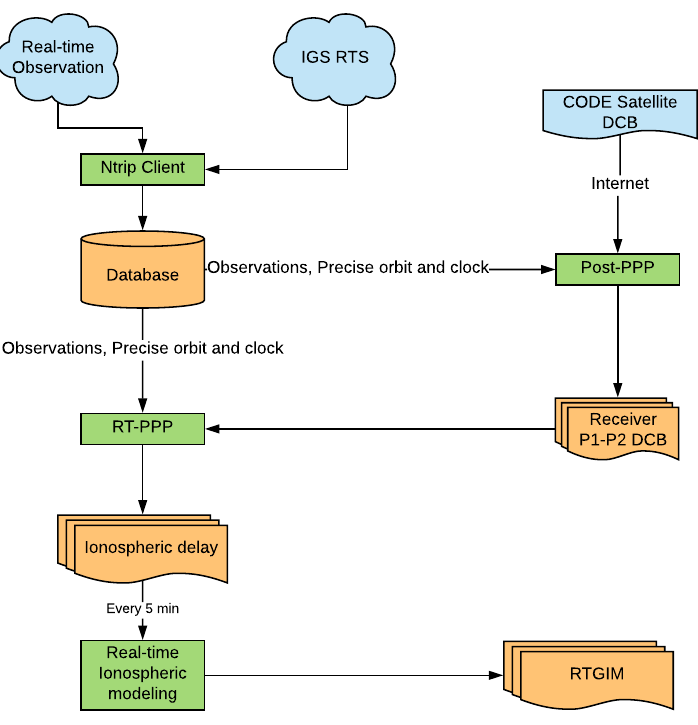
Figure 1. Flowchart of RTGIM